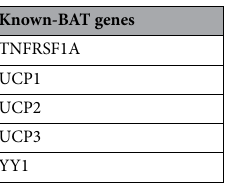
a role of GAB2 in the development and functioning of BAT, as predicted by the BAT connectome. The histamine H4 receptor (HRH4), one of the proteins that mediates the effect of histamine, is another BAT candidate. The HGC also predicted this protein to be biologically close to UCP1, but again, no evidence supported a direct connection until recently. Zhao et al. 23 has reported an increase of HrH4 expression in the subcutaneous WAT of mice exposed to cold conditions. They also reported an impairment of cold-induced browning in WAT of HrH4-KO mice. KO mice showed an impaired up-regulation of thermogenic genes, including Ucp1 and Pgc-1α , along with a worse regulation of temperature and lower heat production in response to cold. Interestingly, the treatment with 4-methylhistamine, an specific agonist of HrH4, increased the browning of subcutaneous WAT in mice. This suggests a role of HRH4 as a novel regulator of browning and cold-induced thermogenesis in white adipose tissue. Therefore, this protein might also play a role in UCP1-related thermogenesis in BAT, as predicted by the HGC. In summary, recent evidence is starting to support the predictions of the BAT connectome. There are BAT candidates with no direct link to BAT but for which current evidence suggests that the association is plausible. Insulin-like growth factor-binding protein 7 gene ( IGFBP7 ) would be an example of this. According to the HGC, IGFBP7 interacts with C-Jun ( JUN ) that in turn interacts with UCP1, thus being IGFBP7 biologically close to UCP1. However, there is currently no direct link between IGFBP7 and UCP1. In this regard, Hu et al. 24 analyzed the impact of IGFBP7 on cattle subcutaneous preadipocytes. They found that knockout preadipocytes for IGFBP7 had lower lipid accumulation and triglycerides formation during maturation compared to controls. In addition, these knockout adipocytes showed lower expression of adipogenic-related genes. Conversely, cattle preadipocytes overexpressing IGFBP7 showed the opposite pattern, i.e., higher lipid accumulation, triglyceride formation and expression of adipogenic-related genes. One of these adipogenic